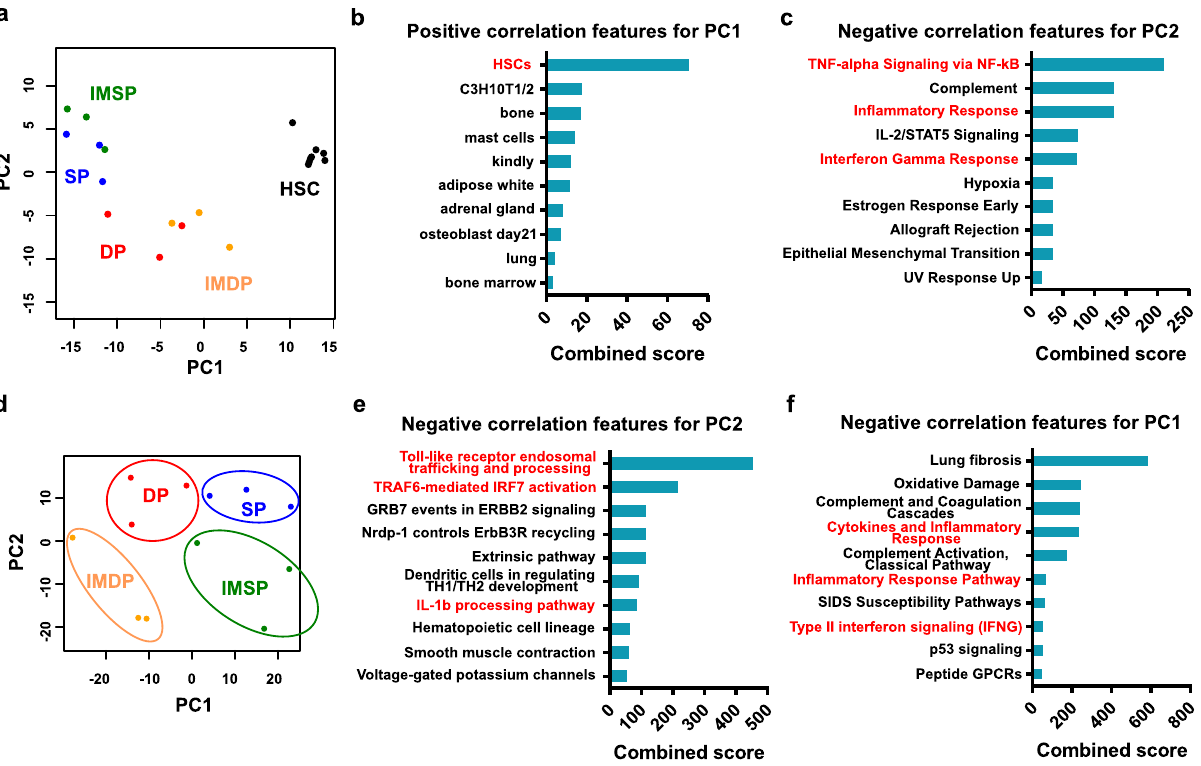
Fig. 2 In fl ammatory signal pathways are enriched in imatinib-insensitive CML-LSCs. a Principal component analysis (PCA) of the gene expression pro fi les of the indicated CML populations (SP, DP, IMSP, and IMDP cells: n = 3 each) and normal HSCs (GSE138884) ( n = 6). b , c Pathway analyses by the Enrichr web tool. Positive correlation features of PC1 ( b ) and negative correlation features of PC2 ( c ) in a . d PCA of the gene expression pro fi les of the four different CML populations. e , f Pathway analyses by the Enrichr web tool. Negative correlation features of PC2 ( e ) and PC1 ( f ) in d